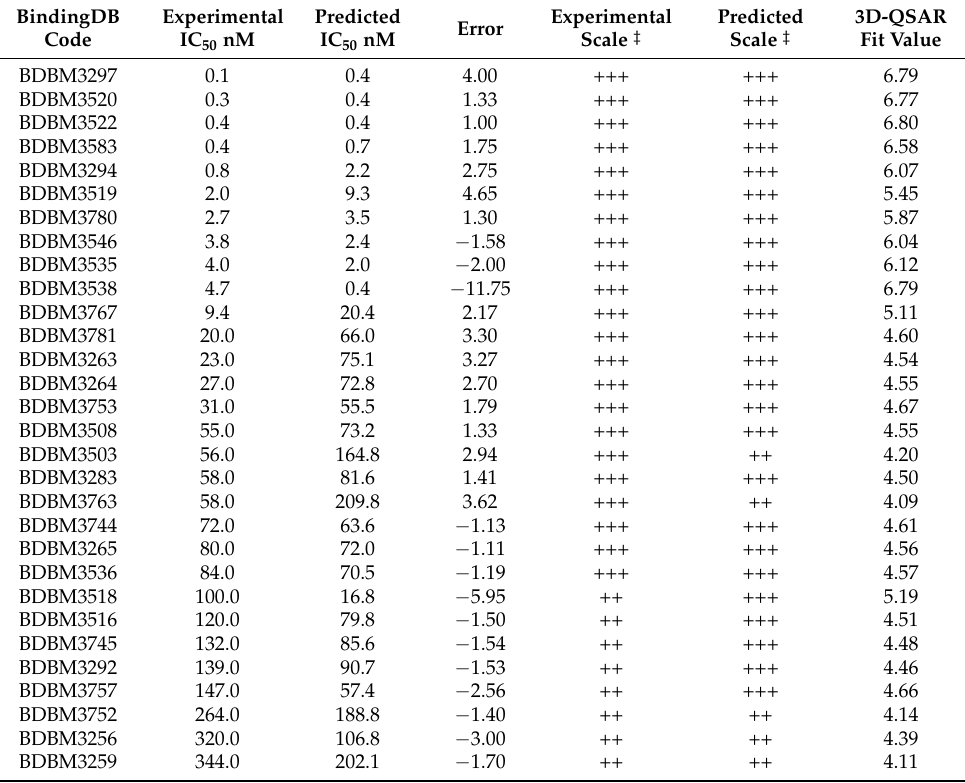
Table 2. The experimental and predicted activities of 33 training set compounds calculated on the basis of the 3D QSAR-derived Hypo1